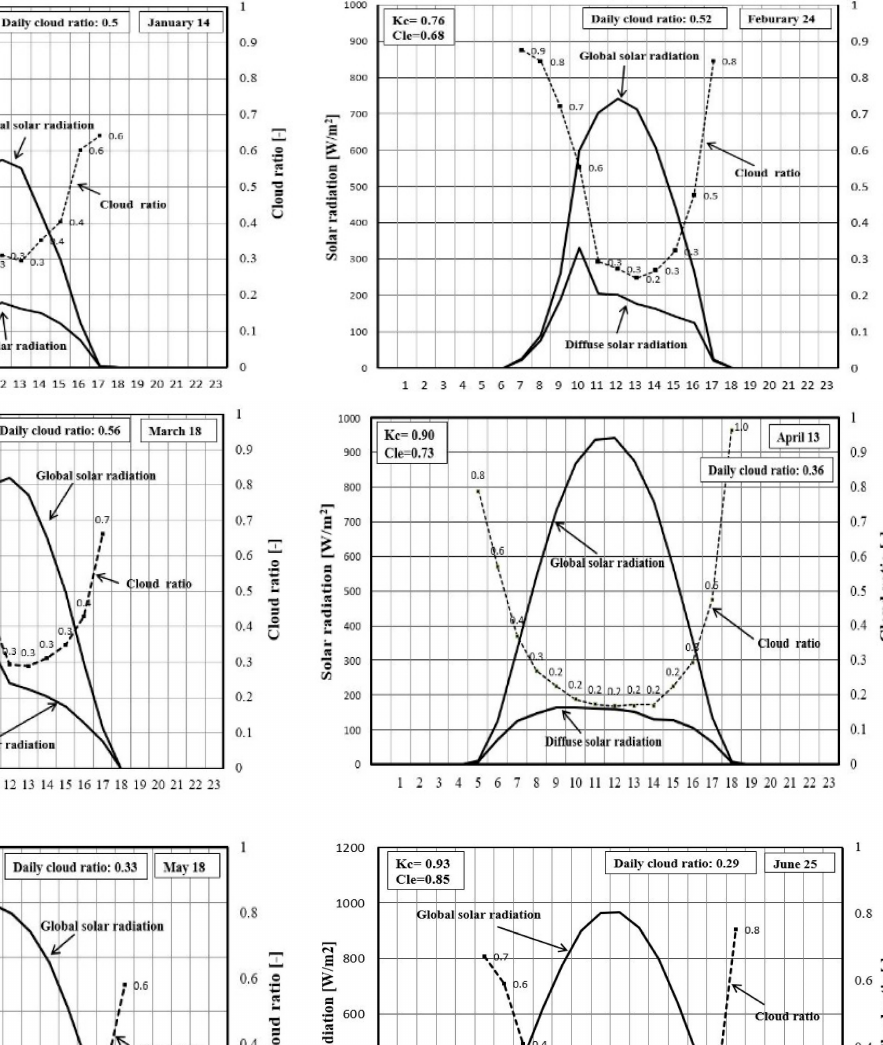
Figure 5. Actual observed solar radiation (diffuse irradiance and global irradiance) from January to September, 2011 in Shanghai, China; please note that the observation that zero values of irradiance in the figures correspond to night hours. The observation solar radiation in this paper is only a single year’s data for Shanghai, thus we considered the fact that data exposed in this section are just indicative for a low accuracy concerning CSWD cloud ratios data for the town of Shanghai, China.